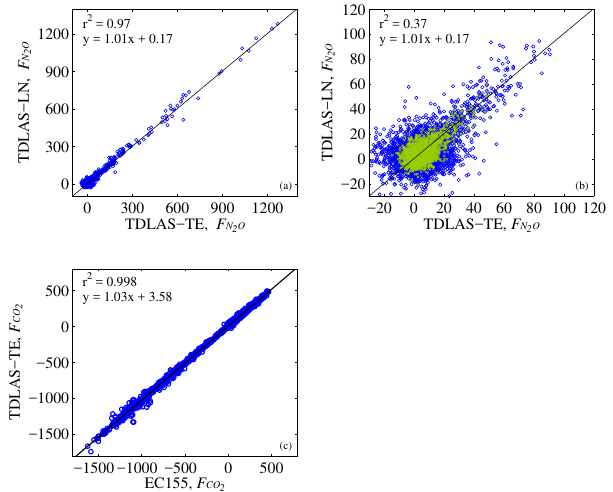
Figure 6. Comparison of 30min fluxes measured by each ana- lyzer. Panel (a) displays the comparison of N 2 O–N fluxes (ngN 2 O– Nm − 2 s − 1 ) for the entire data set, panel (b) shows the same N 2 O–N flux data set (ngN 2 O–Nm − 2 s − 1 ) but centred on the low flux val- ues. The green “x” markers in panel (b) are the fluxes measured when the standard deviation of background N 2 O concentrations for both analyzers was less than 2ppbN 2 O. Panel (c) is the comparison of F CO between TDLAS-TE and EC155 (µgCO 2 m − 2 s − 1 ) . 2 4 Discussion